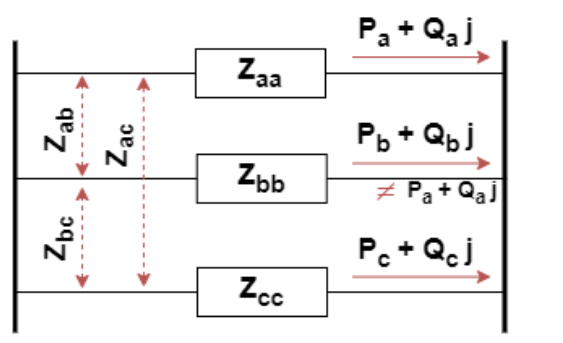
Figure 3. Unbalanced phases in the distribution